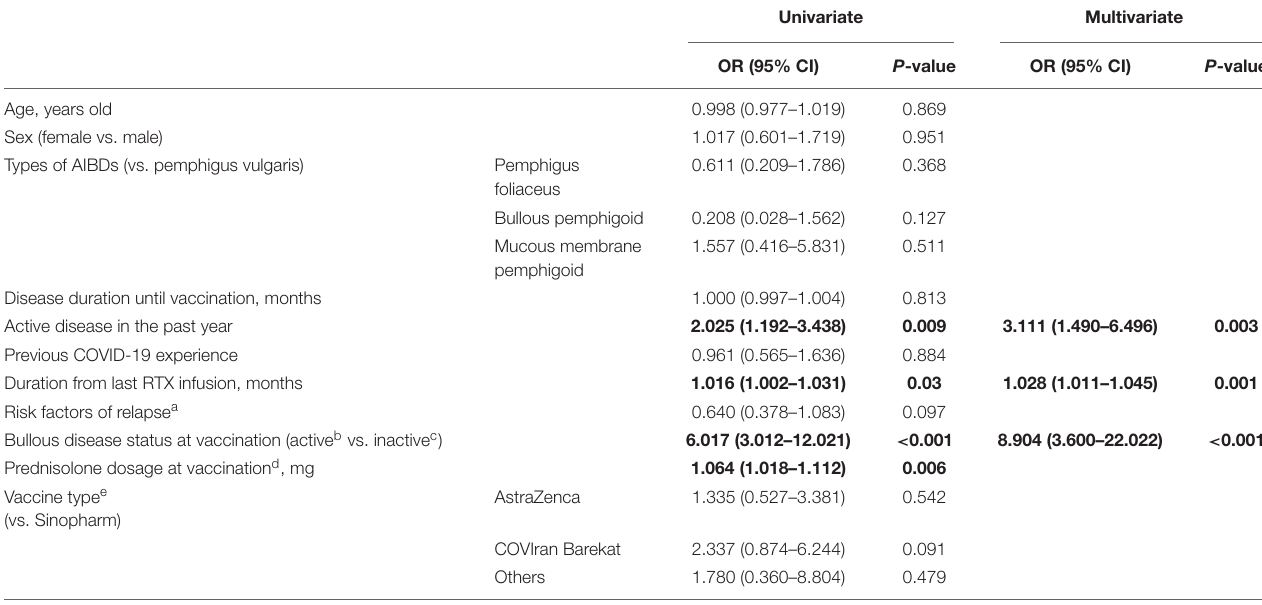
TABLE 2 | Univariate and multivariate analysis for the probable factors of post-vaccination disease exacerbation in patients with